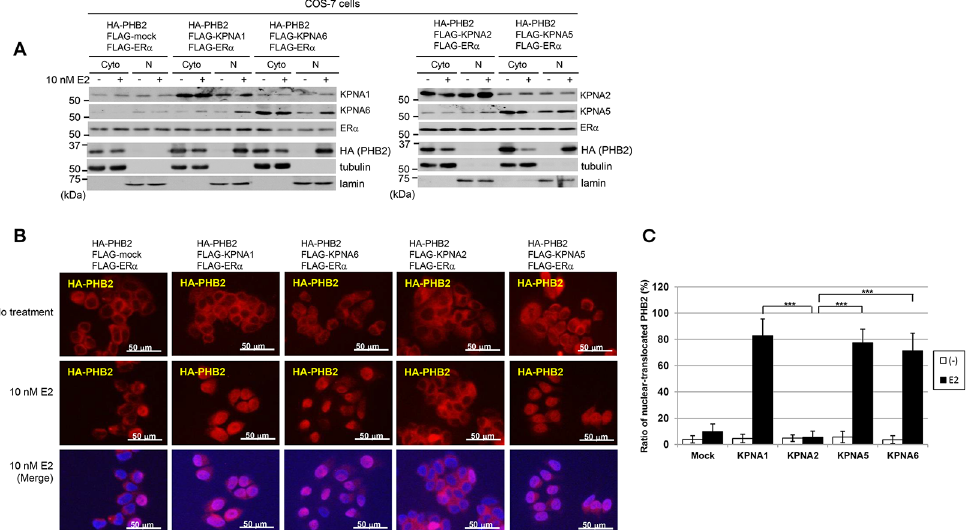
Fig 2. KPNA mediates the nuclear translocation of PHB2. (A) Immunoblotting analysis was performed to detect the subcellular localization of KPNA, ER α and PHB2. COS-7 cells co-transfected with HA-PHB2, each FLAG-KPNA and FLAG-ER α were treated with 10 nM E2 for 24 h and separated into cytoplasmic and nuclear fractions. Each KPNAs and ER α were detected by endogenous antibody. α / β -Tubulin (tubulin) and lamin B1 (lamin) were used as loading controls for the cytoplasmic (Cyto) and nuclear (N) fractions, respectively. (B) Representative immunofluorescence images of the subcellular localization of HA-PHB2 in COS-7 cells are shown; HA-PHB2 (red), DAPI (blue). (C) Statistical analyses of the nuclear intensity of translocated PHB2. The data represent the mean ± SD of four different points ( *** P < 0.001 in a two-sided Student ’ s t -test).